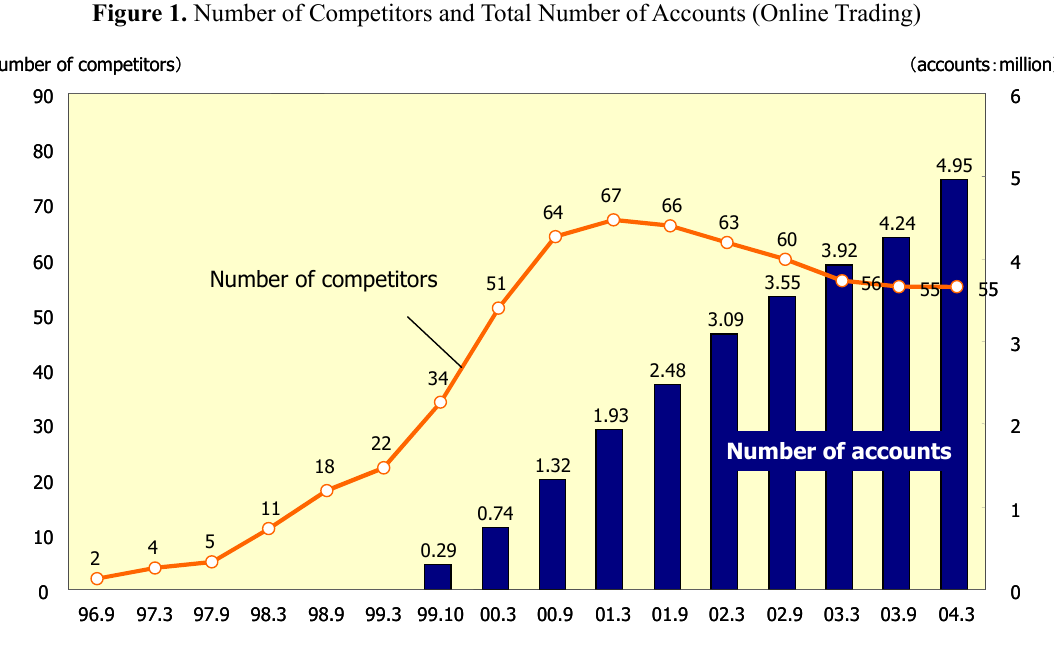
Figure 1. Number of Competitors and Total Number of Accounts (Online